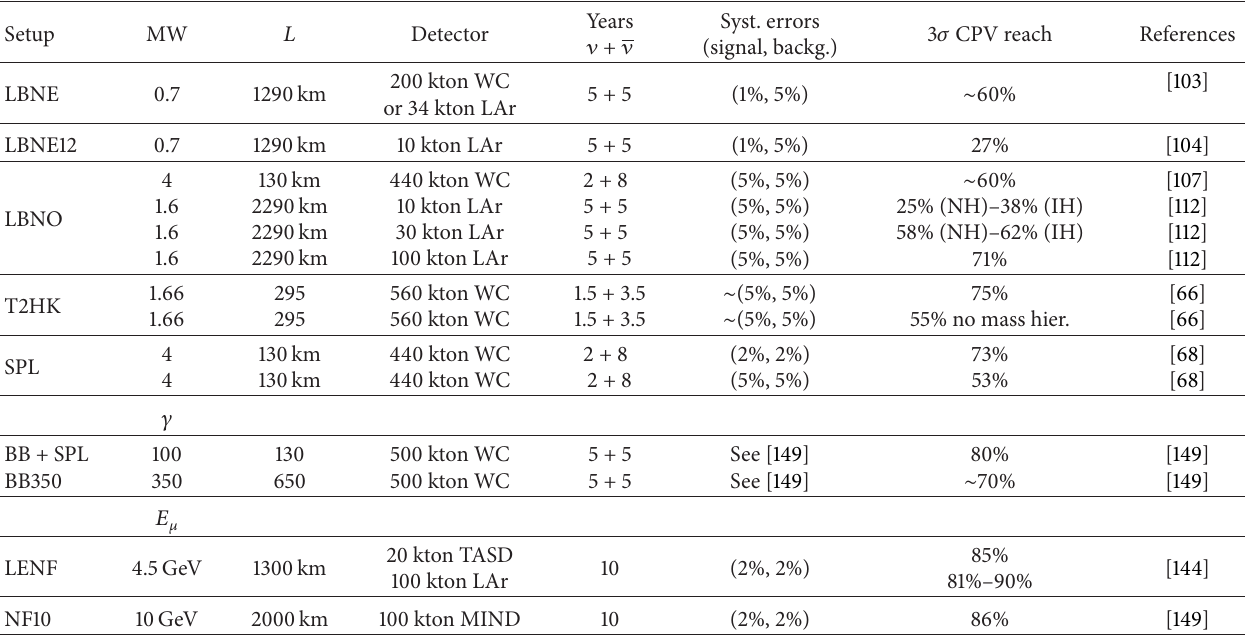
Table 4: Summary of the setups described in the text. From left to right, the columns list the names of the setups, the beam power for superbeams or 𝛾 factor for beta beams or muon energy for neutrino factories, the baseline, the detector choice, the running time in years for each polarity (the neutrino and antineutrinos runs are simultaneous for the neutrino factory), the systematic error on the signal and background, the fraction of the values of 𝛿 for which CP-violation could be determined at 3 𝜎 at sin 2 2𝜃 13 = 0.1 , and the reference from which the information has been collected. For LBNO with 10 kton and 30 kton LAr detectors, the values of the fraction of 𝛿 are given separately for a true normal (NH) or inverted (IH) hierarchy. The number of seconds per year is 1.7 × 10 7 for LBNO and 1 × 10 7 for T2HK. BB + SPL considers the combination of the betabeam with 1.1 × 10 18 ( 2.8 × 10 18 ) 18 Ne ( 6 He) useful decays per year together with the SPL described above (with a 500 kton WC detector instead of a 440 kton one). The LENF uses 1.4×10 21 useful muon decays per year per polarity, and NF10 7 × 10 20 . The results quoted depend significantly on the assumptions made in the analysis and should be treated carefully. Syst. errors Years 3 𝜎 CPV Setup MW 𝐿 Detector 𝜈 + 𝜈 (signal, backg.)